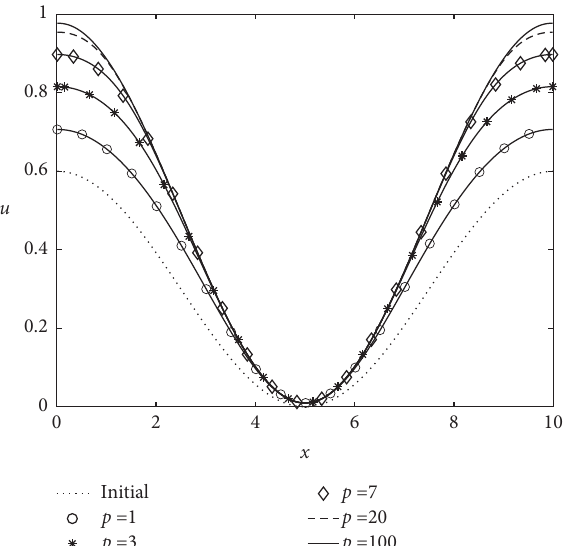
Figure 10: Snapshots of the numerical solutions of the Fisher–KPP equation with the initial condition u ( x, 0 ) � 0 . 3 cos ( π x /5 ) + 0 . 3. Here, t � 0 . 5 with Δ t � 0 . 001 and p � 1 , 3 , 7 , 20, and 100.